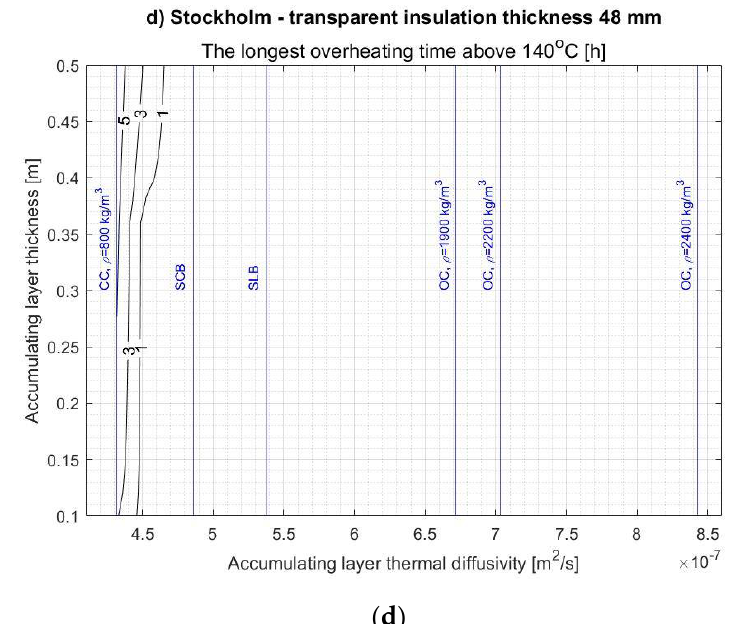
Figure A1. Contour graphs characterizing the SW basic parameters in a function of AL thermal diffusivity and thickness for the whole heating season: ( a ) the heat balance of the SW’s unit area, ( b ) the heating time, ( c ) the mean time lag of the maximum temperature on the absorber and SW’s internal surface during the day, ( d ) the longest overheating time above 140 °C in the TI. TI thickness: 48 mm. Location: Stockholm.